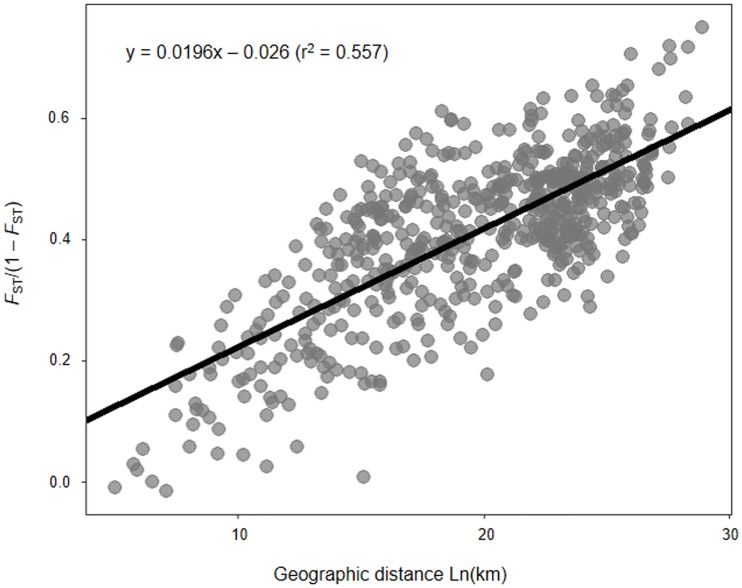
Relationship between genetic distance and the log of the geographical distance for B. tabaci MED.The line represents the regression line and circles represent the logarithm transformation of distance (p = 0.01, 1,000 permutations).